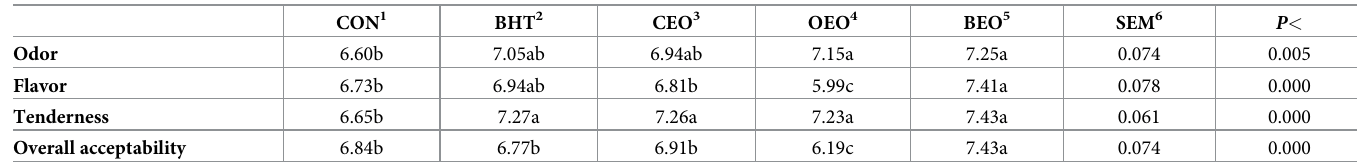
Table 5. Consumer acceptability of beef patties treated with BHT, copaiba and oregano essential oil or blend of essential oils ( n = 124 consumers) § . CON 1 BHT 2 CEO